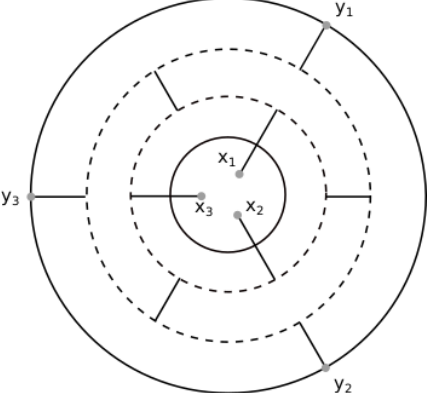
Figure 6 . An example of bulk of planar diagram appearing in the perturbative expansion of h Tr[ (cid:30) 3 ]( x )Tr[ (cid:30) 3 ] y ( y ) i . It mixes together a square lattice structure of quartic scalar interactions and j j the \brick-wall" domain made by Yukawa interactions. This case corresponds to the operatorial expression ^ H (3) ( ^ H (3) ) 2 H (3) ( x 1 ; x 2 ; x 3 j y 1 ; y 2 ; y 3 B F B